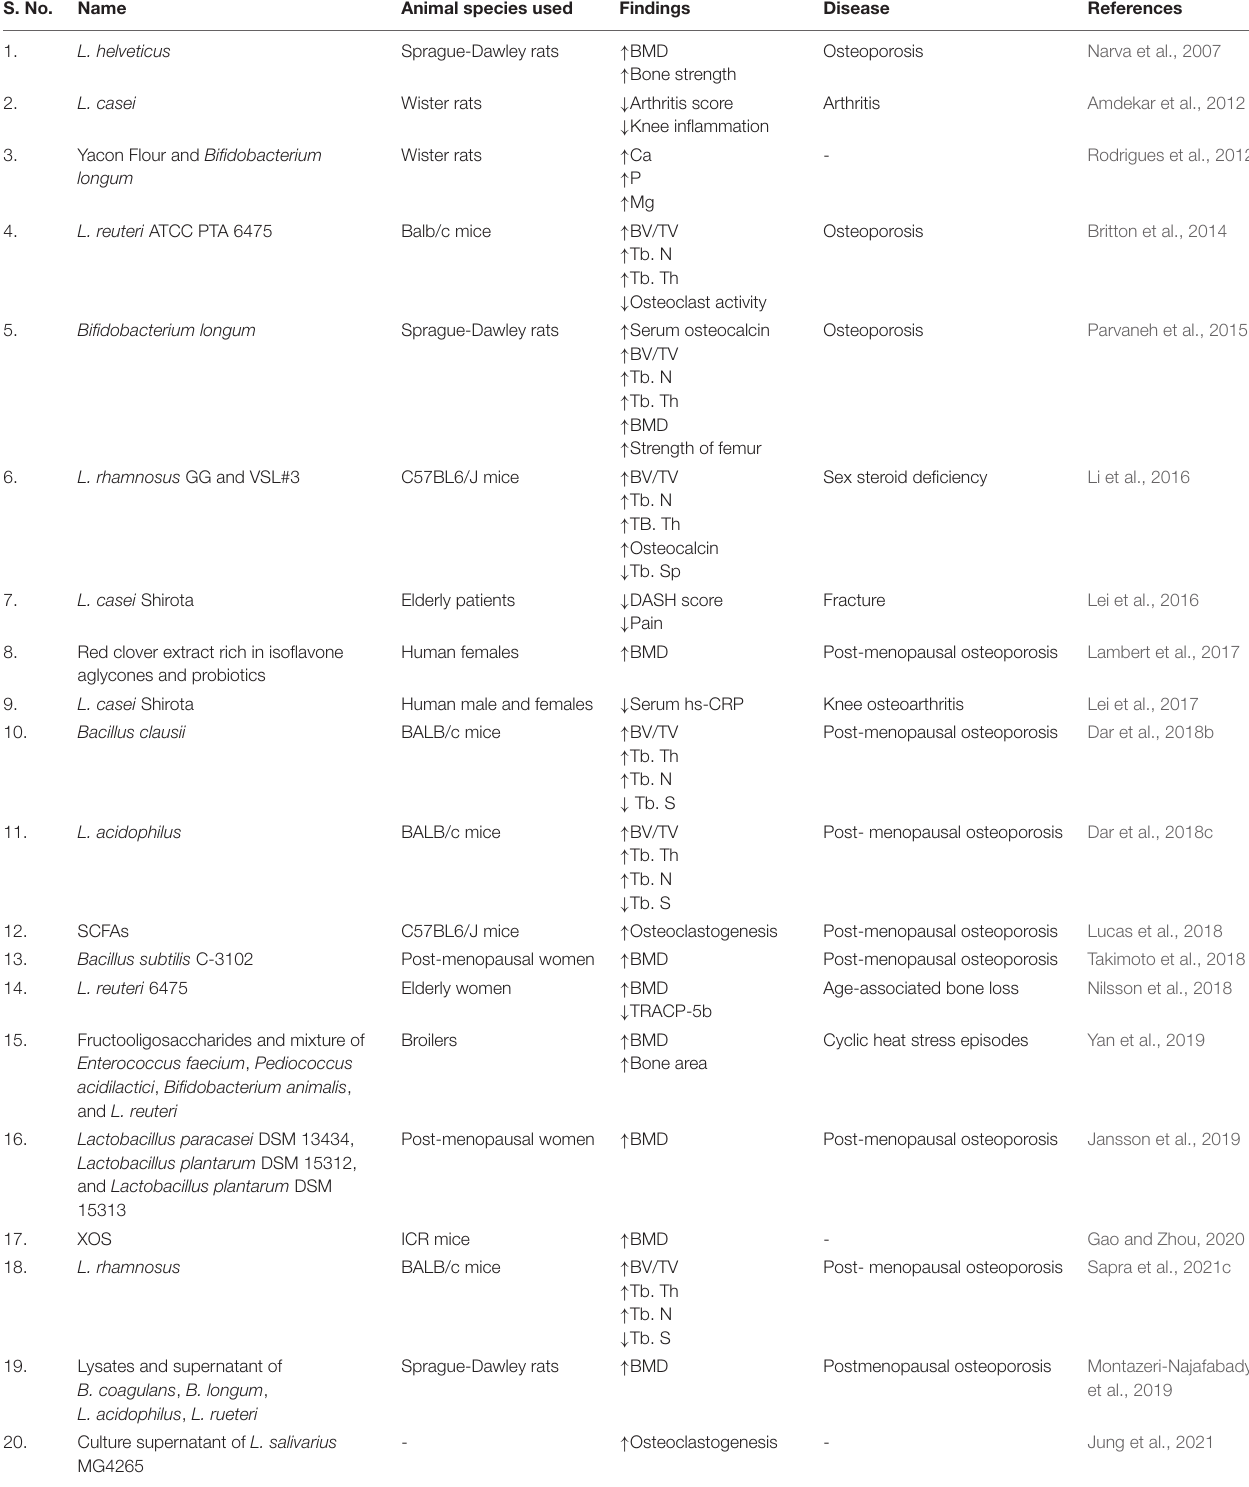
TABLE 1 | Role of various Biotics in regulating bone